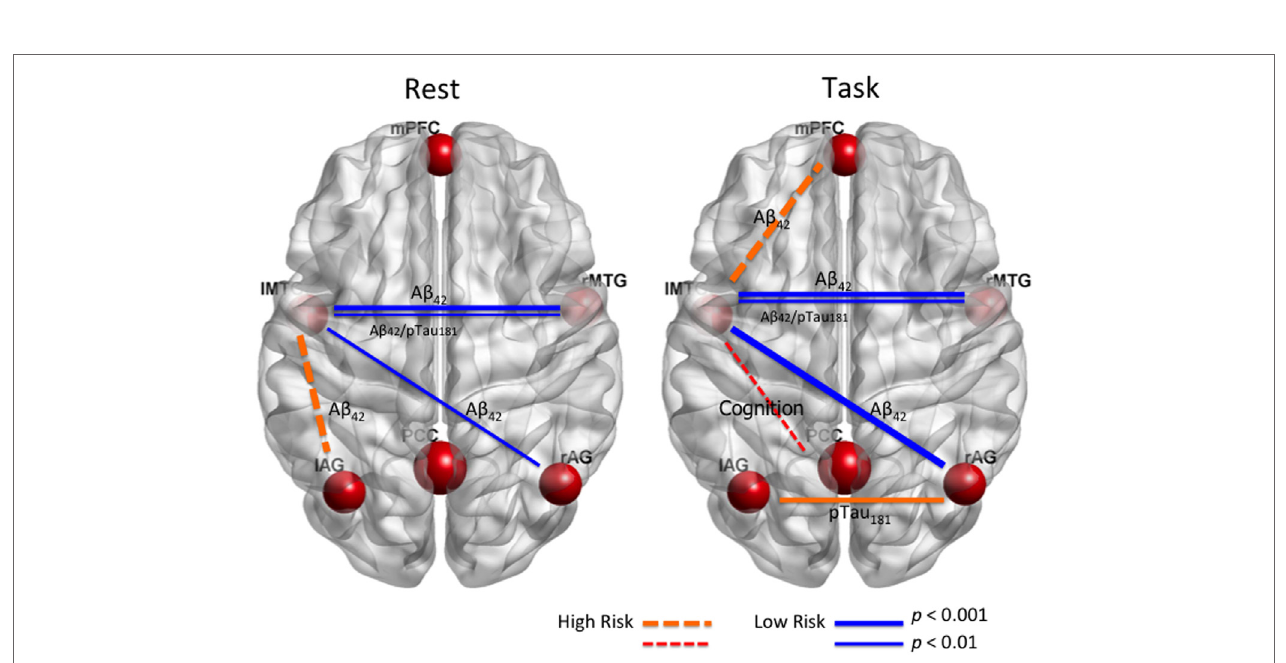
FigUre 5 | summary results of relations between functional brain connectivity within DMn during resting state and task, csF biomarkers (a β 42 and pTau 181 ), and global cognition ( T -scores) in cognitively normal older adults. Blue lines indicate low AD risk, and orange/red lines indicate high AD risk. The stronger the line, the more significant the connectivity with CSF biomarker or cognition. Solid line shows that the correlation was significant in more than one analysis. Left MTG appears to be a hub for connectivity sensitive to AD